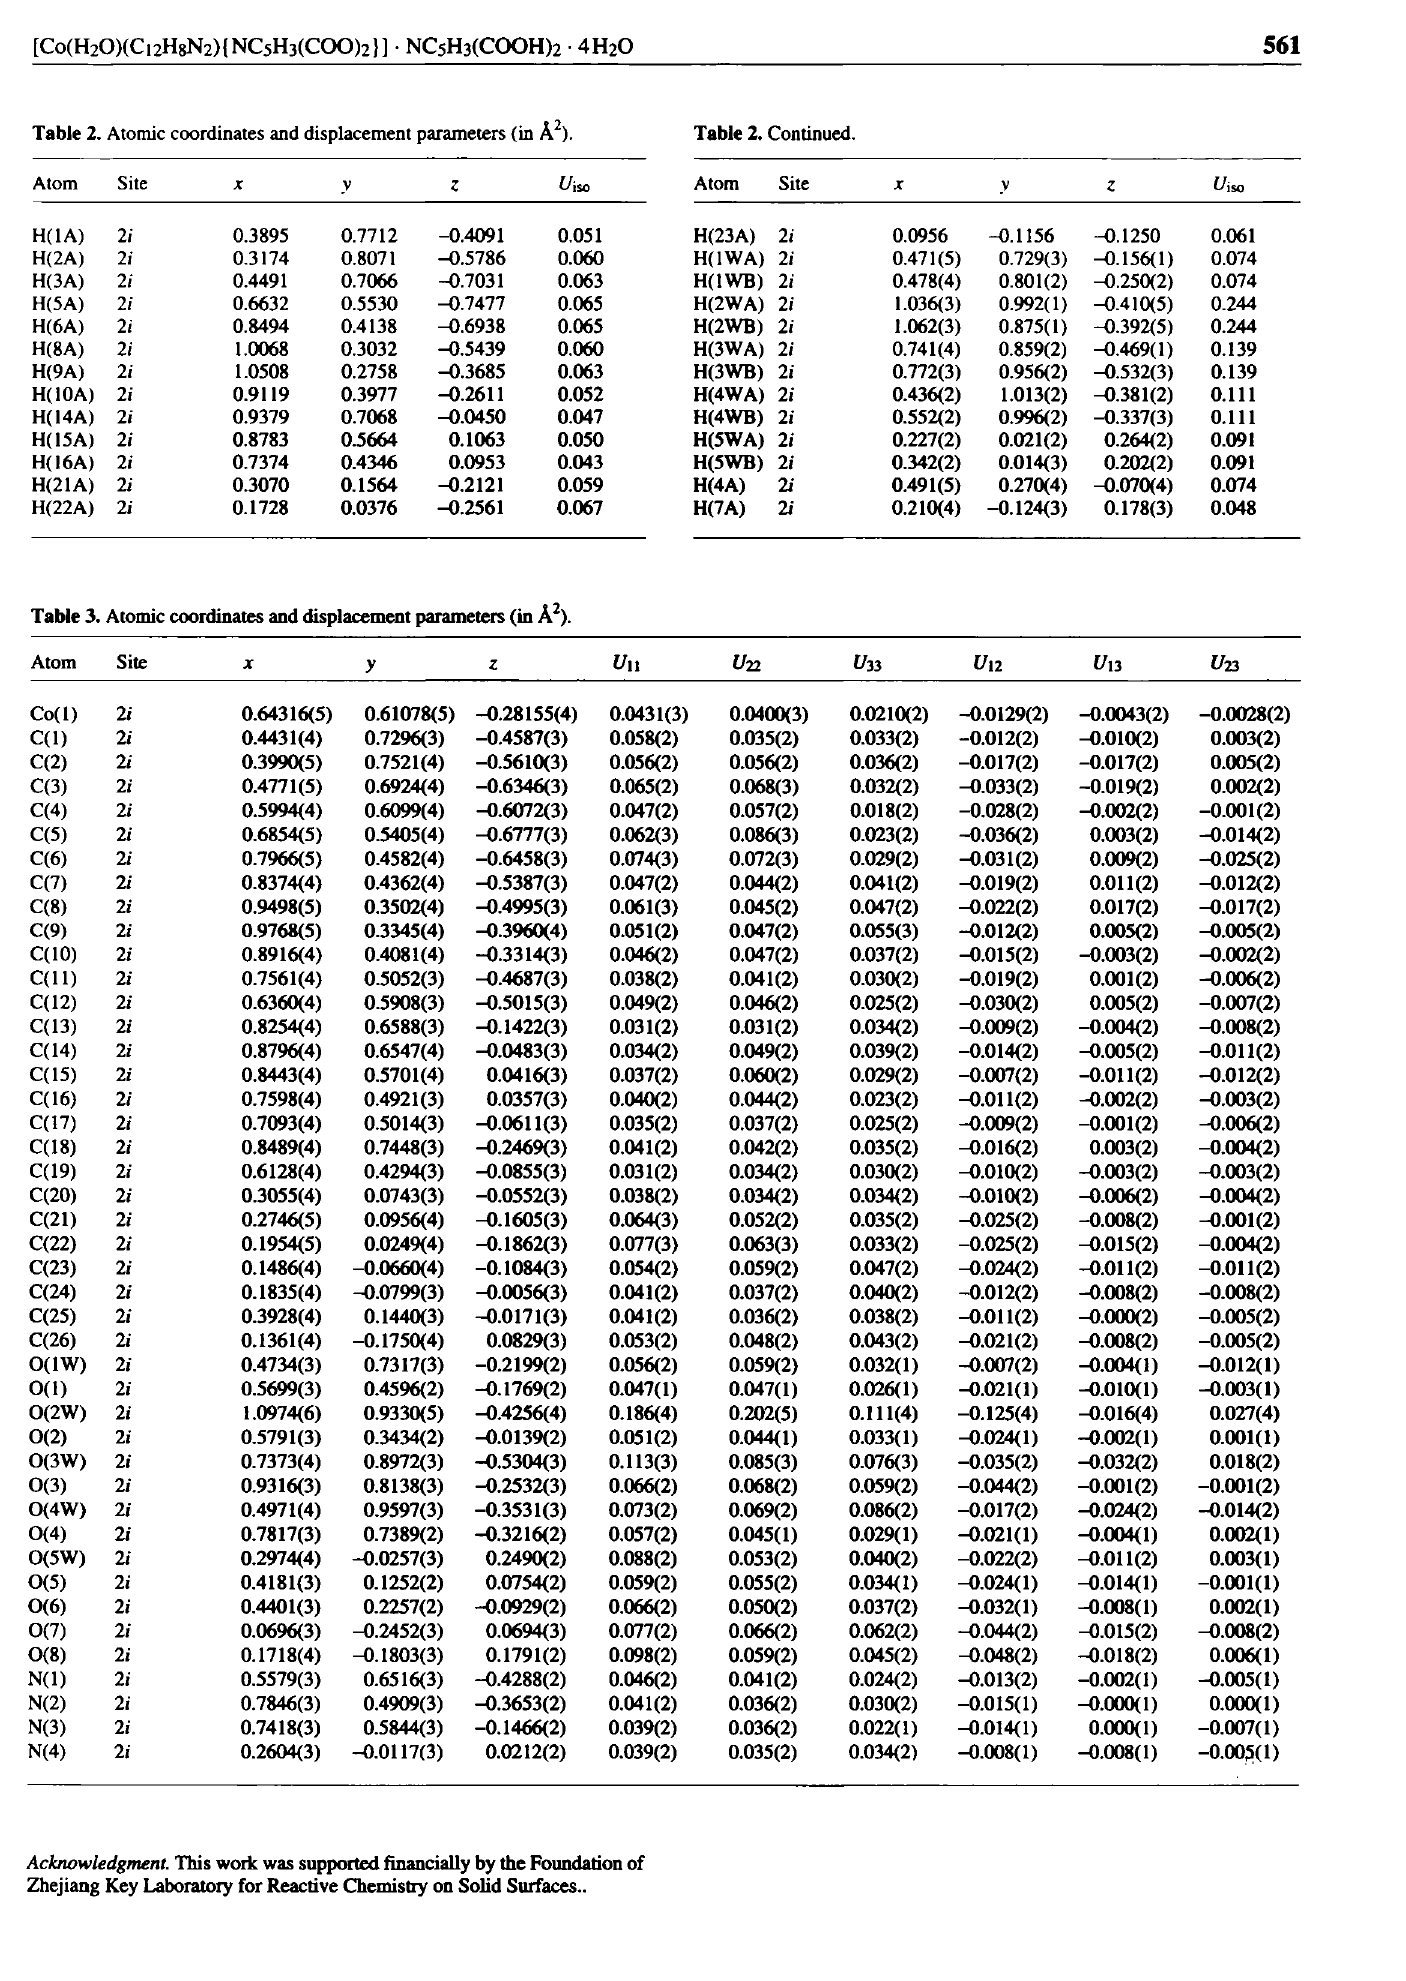
Table 2. Atomic coordinates and displacement parameters (in Ä 2 ). Table 2. Continued.